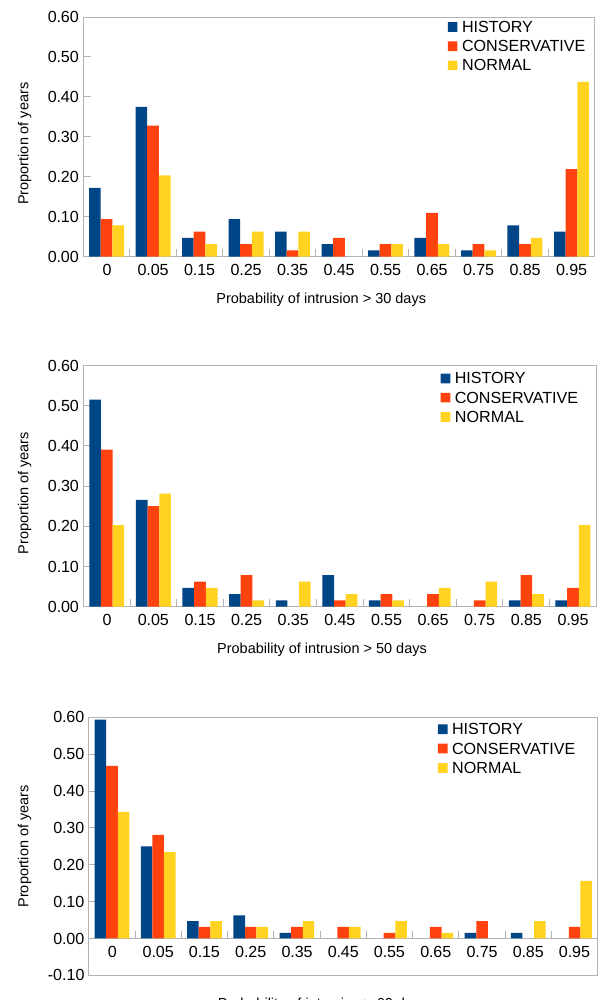
Figure 8. Impact of normal and conservative operating rules for the Three Gorges Dam, South–North Water Transfer Project and local abstractions on probabilities of intrusions of 30, 50 and 60